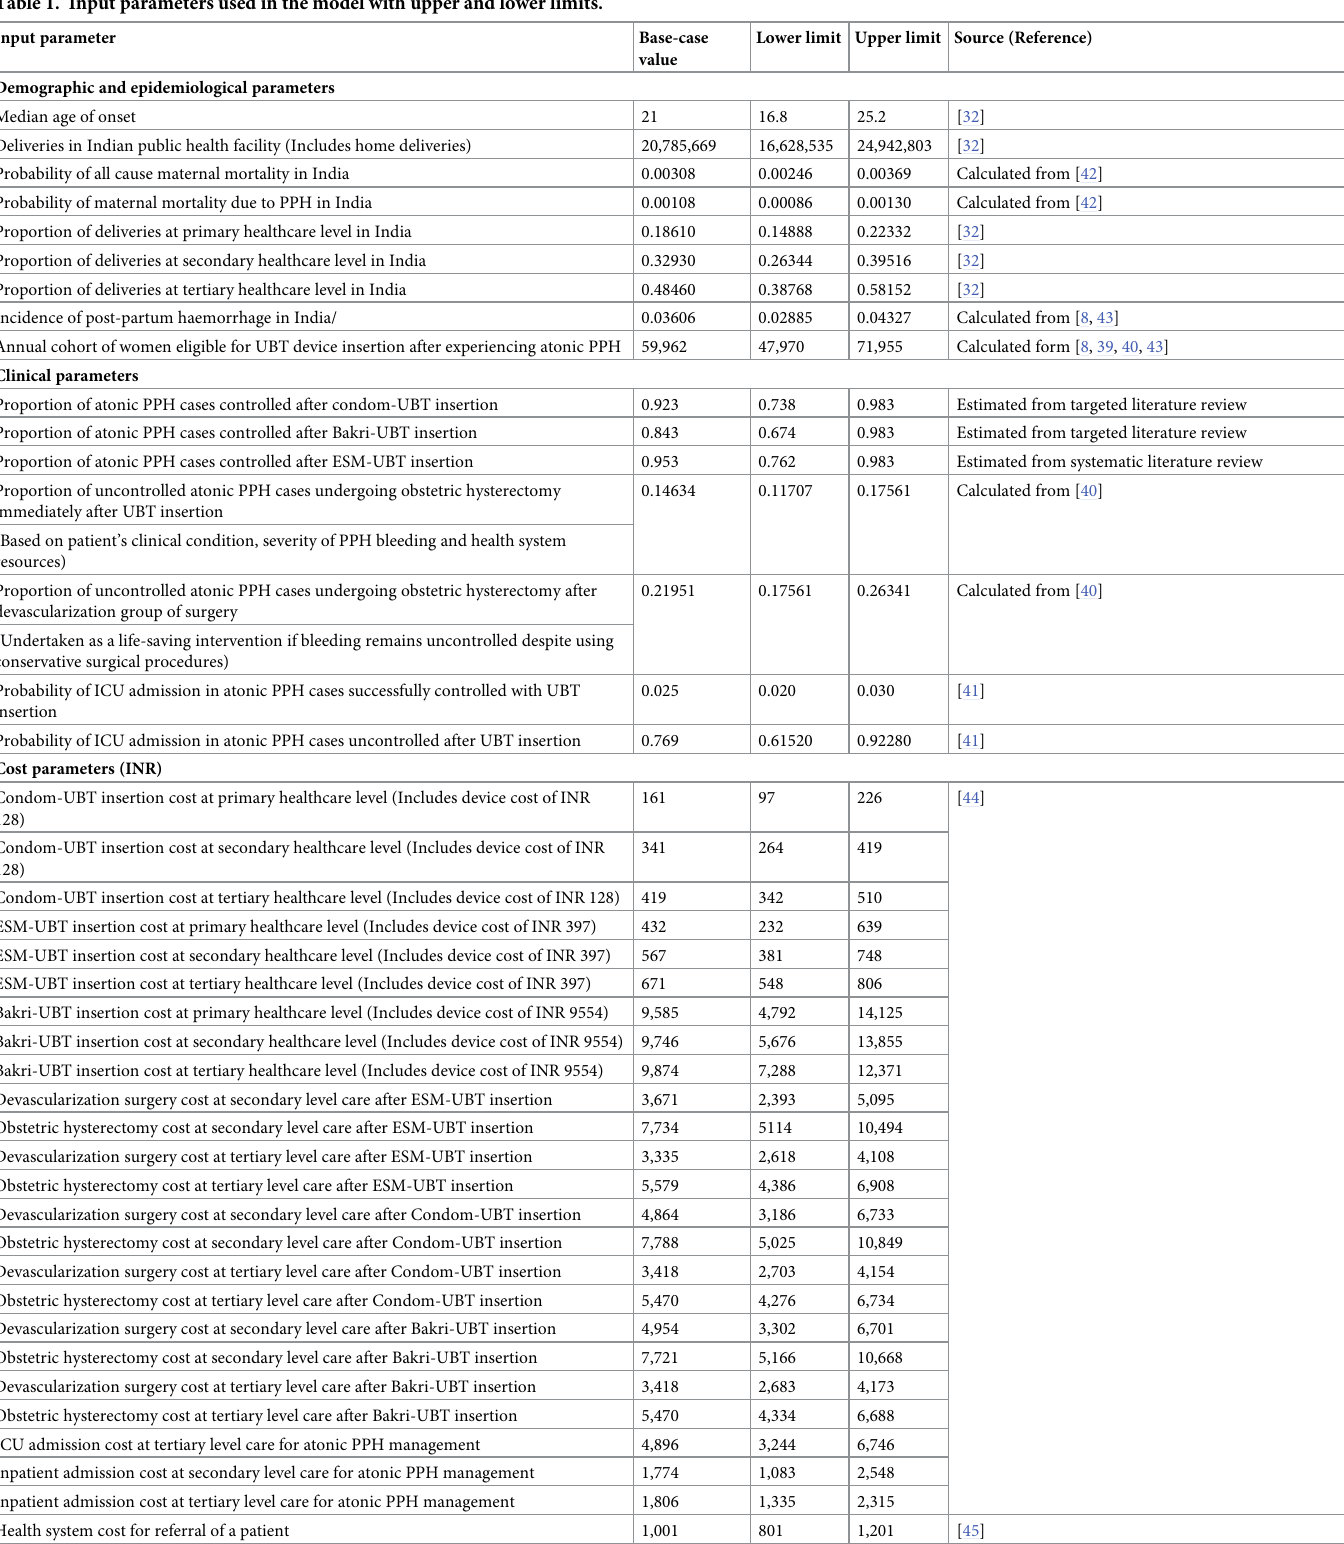
Table 1. Input parameters used in the model with upper and lower